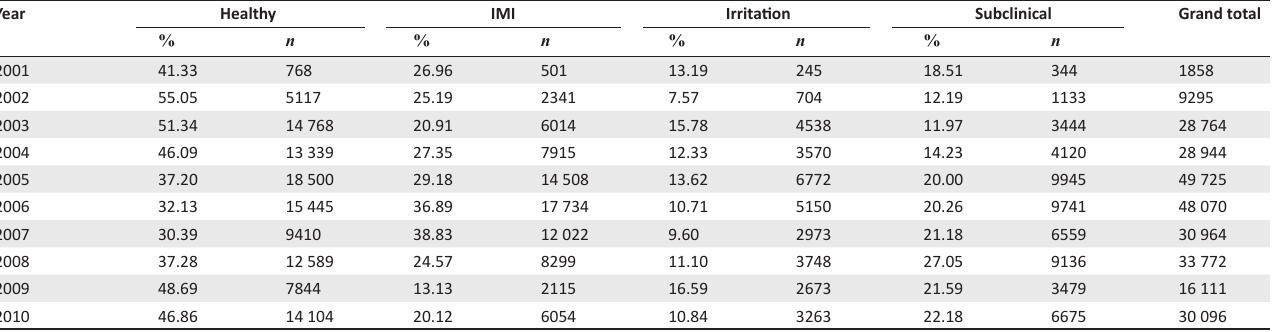
TABLE 3: Health status and intramammary infections of the 20 herds on which management practices were altered as determined and projected by the Milk Sample Diagnostic programme used in practice (for all Staphylococcus aureus isolates).